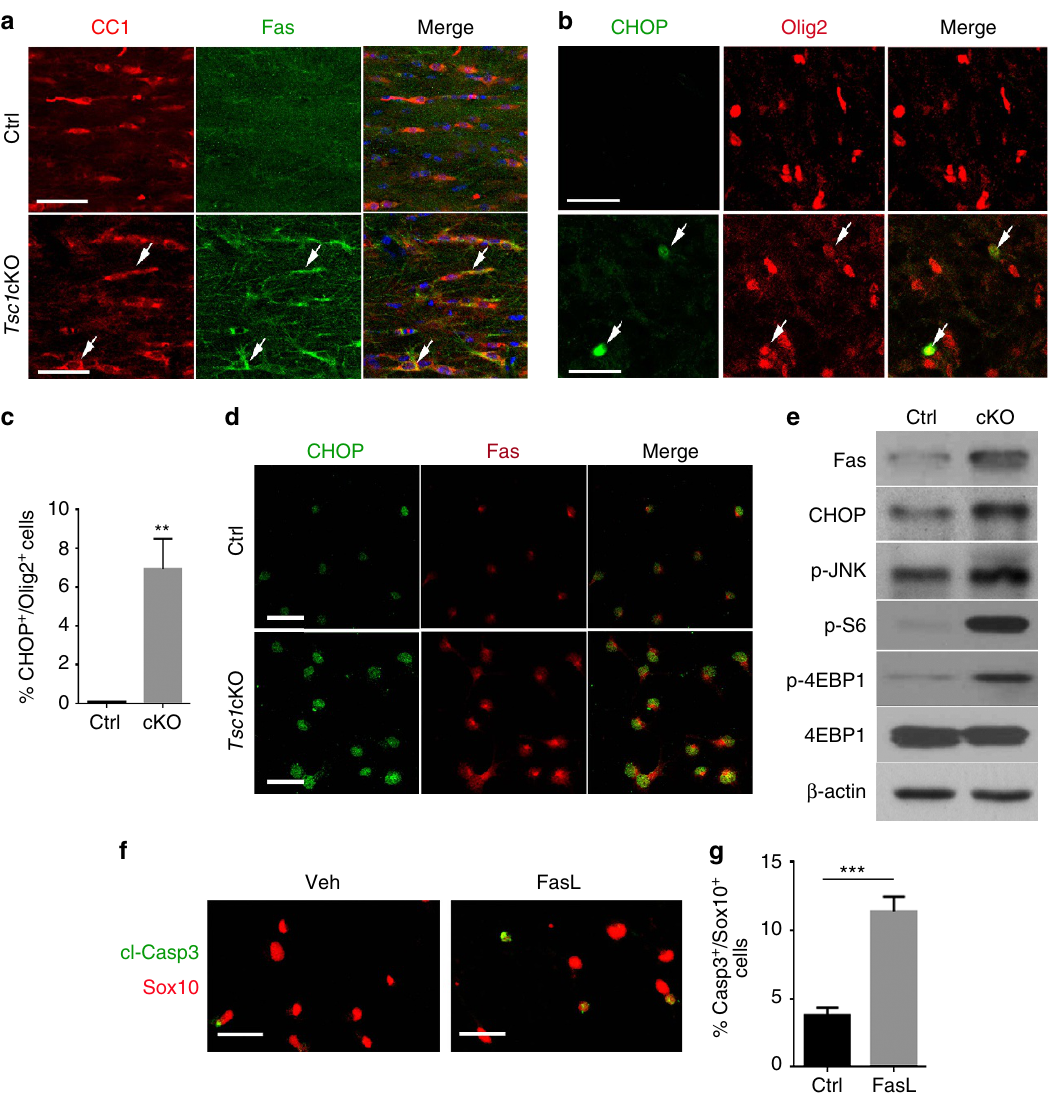
Figure 6 | Tsc1 ablation activates cell apoptotic program. ( a , b ) Representative images showing the corpus callosum of P14 control and Tsc1 cKO mice immunostained with antibodies to ( a ) Fas and CC1, and ( b ) CHOP and Olig2. Scale bars, 25 m m. ( c ) Percentage of CHOP þ /Olig2 þ cells in control and Tsc1 cKO cortices at P14. Data represent the mean ± s.e.m. from three animals. * P o 0.05; ** P o 0.01; *** P o 0.001; Student’s t -test. ( d ) Primary OPCs from control and Tsc1 cKO pups cultured in T3-containing differentiation medium for 24h were immunostained with CHOP and Fas. Scale bars, 25 m m. ( e ) Western blot analysis of extracts from primary OPCs isolated from control and Tsc1 cKO animals with antibodies to Fas, CHOP, p-JNK, p-S6 and p-4EBP1; b -actin: loading control. ( f ) Primary OPCs from wild-type mice were treated with solvent and 100ngml (cid:2) 1 FasL for 24h, and immunostained with antibodies to cl-Casp3 and Sox10. Scale bar, 25 m m. ( g ) Percentage of cl-Casp3 þ /Sox10 þ cells from above wild-type OPCs treated with FasL. Data represent the mean ± s.e.m. from three independent experiments. *** P o 0.001; Student’s t